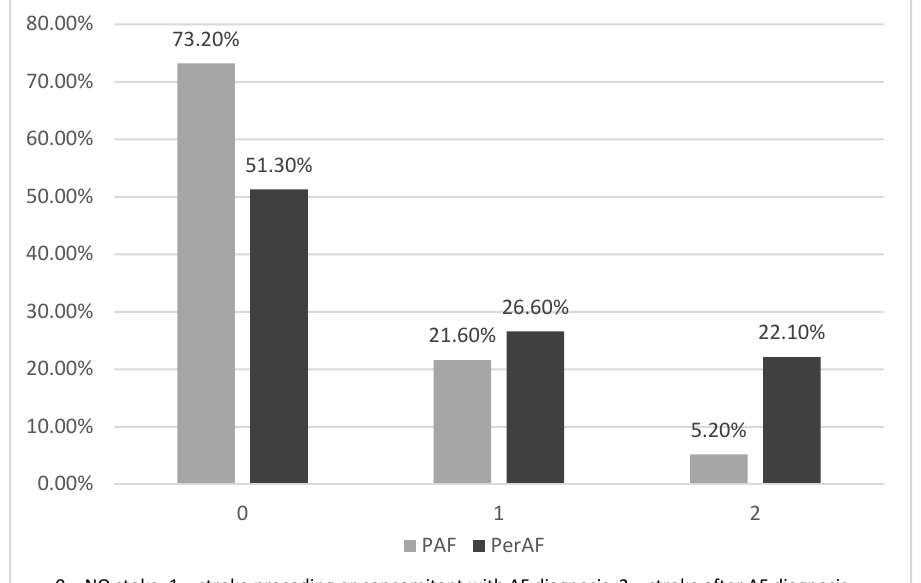
Figure 4. Stoke’s repartition regarding onset time related to the AF diagnosis (PAF—paroxysmal atrial fibrillation, PerAF—permanent atrial fibrillation).